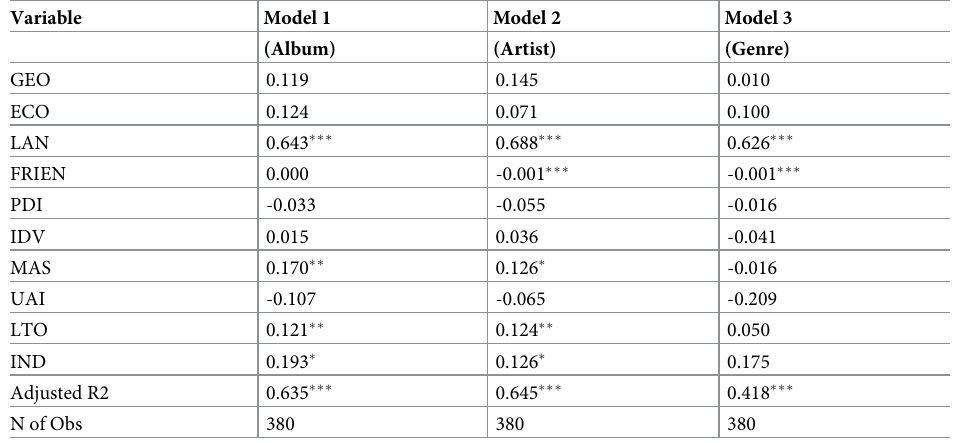
Table 2. The QAP regression